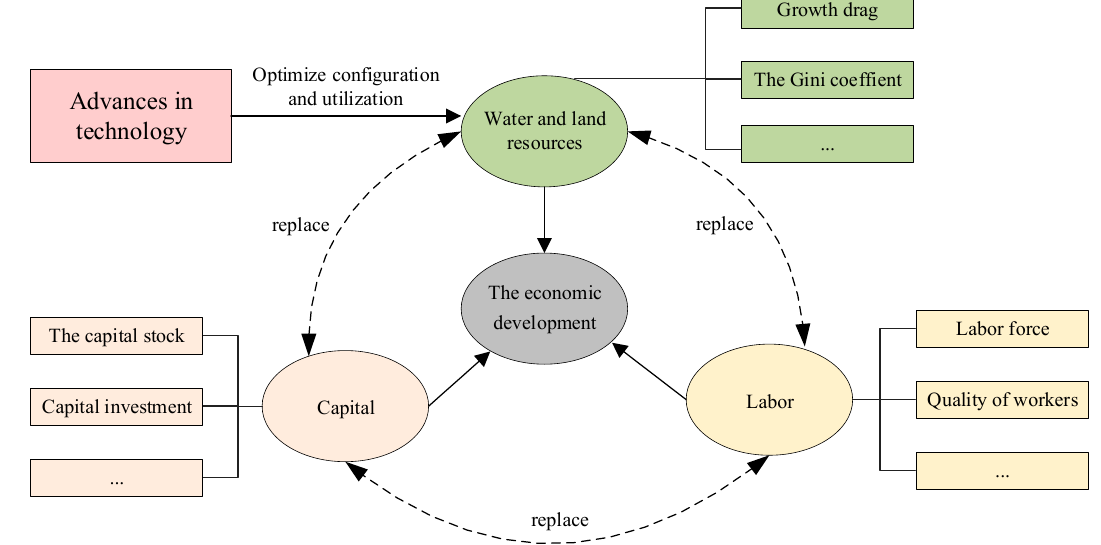
Figure 1. Analysis framework of economic development driving